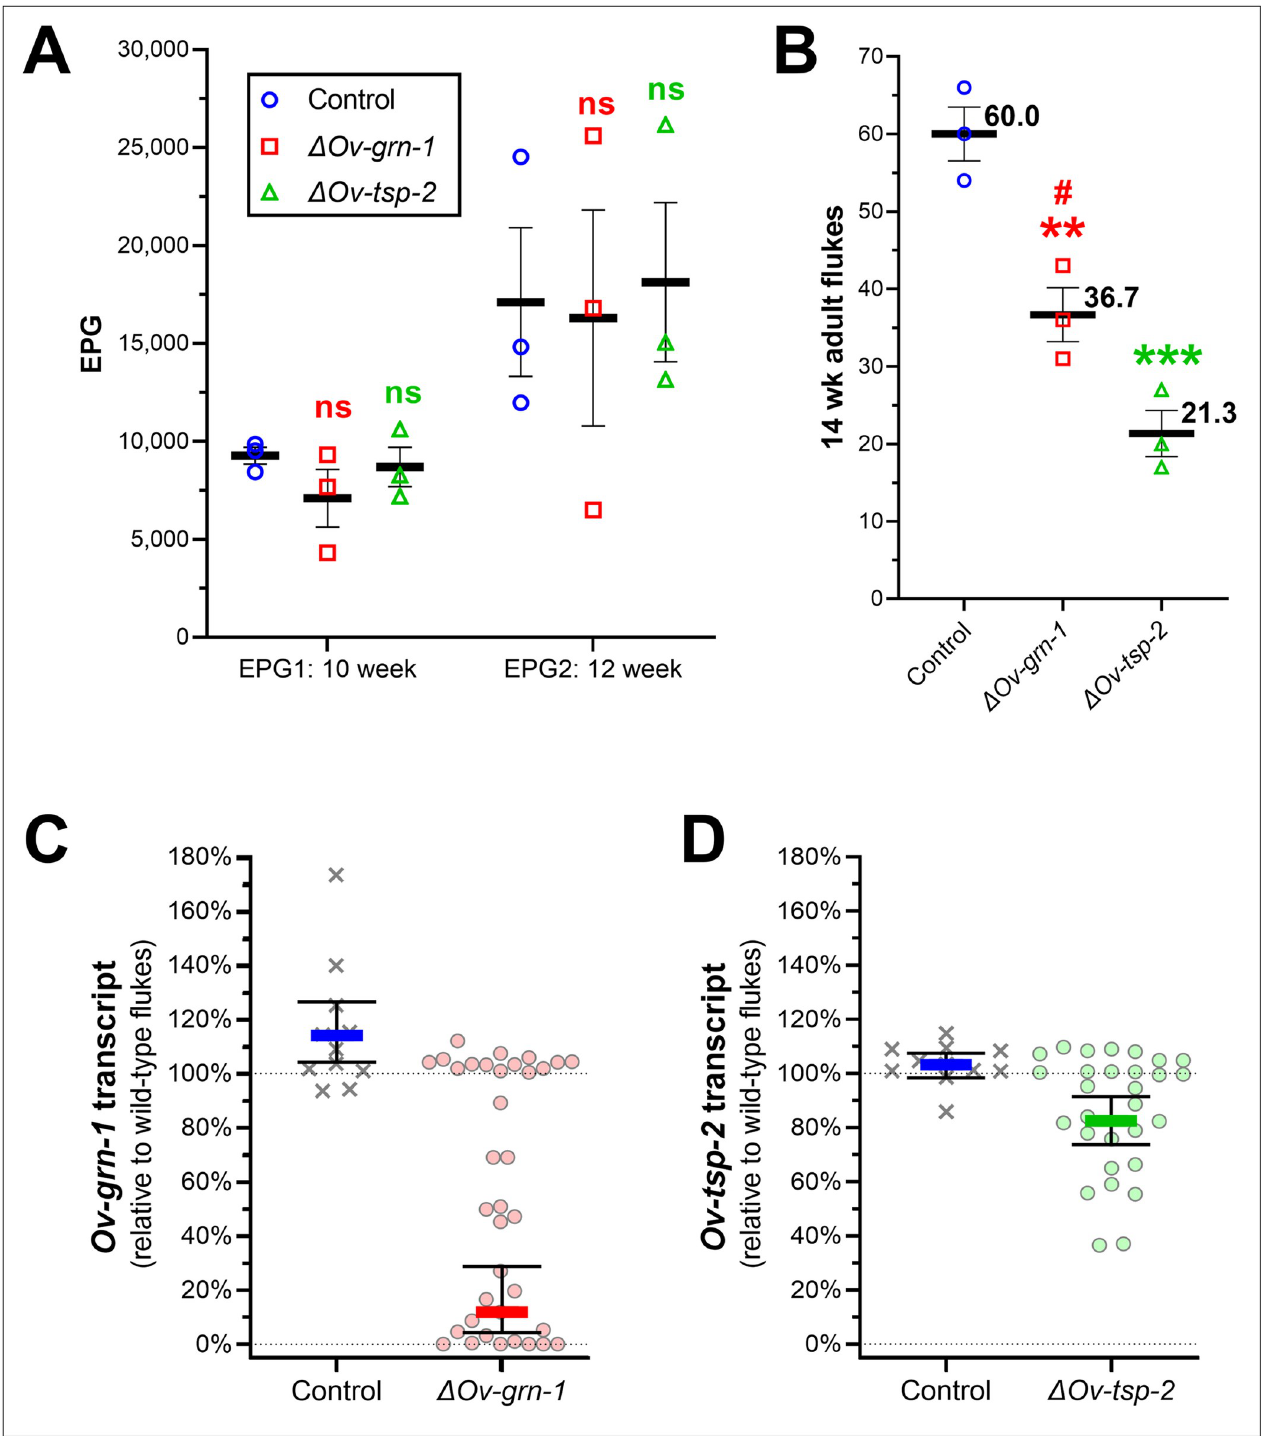
Fig 2. Liver fluke burden and levels of gene transcription. Fecundity, worm numbers, and gene expression levels were determined at 10–14 weeks after infection of the hamsters with 100 gene edited juveniles, and from three hamsters per group (Experiment 1). Number of eggs per gram of feces ( EPG ) from each hamster at weeks 10 and 12 (A) and worm numbers at week 14 (B) showing mean (horizontal black line) and SEM bars. Each treatment group was compared to the control group in 2-way ANOVA with Holm-Sidak multiple comparison: ns = not significant; �� , P � 0.01; ��� , P � 0.001, and Δ Ov-grn-1 against Δ Ov-tsp-2 : #, P � 0.05. Gene transcript levels of Ov-grn-1 (C) and Ov-tsp-2 (D) were determined by qPCR for 10 to 13 flukes sampled from each animal